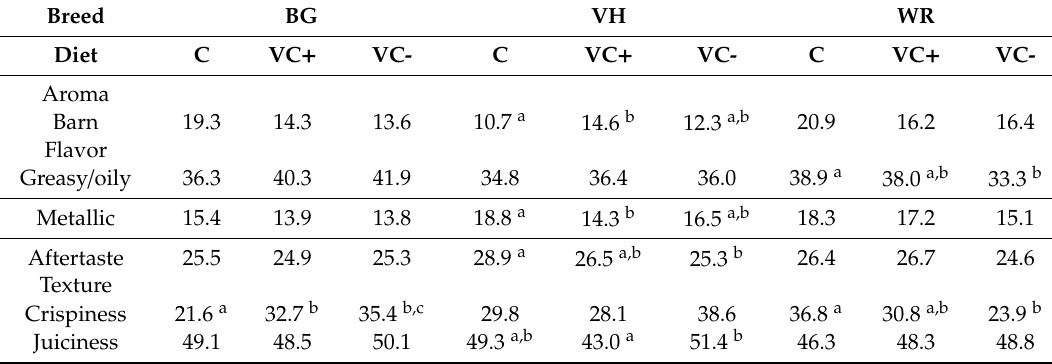
Table 5. Estimated marginal means of statistically significant ( α = 0.05) sensory attributes ( n = 10, r = 2), as quantified using unstructured line scales (0 = not perceptible, 100 = strongly perceptible), of leg samples per breed (BG = Bresse Gauloise, VH = Vorwerkhuhn, WR = White Rock) and feed (C = control, VC + = high in vicin, VC- = low in vicin).